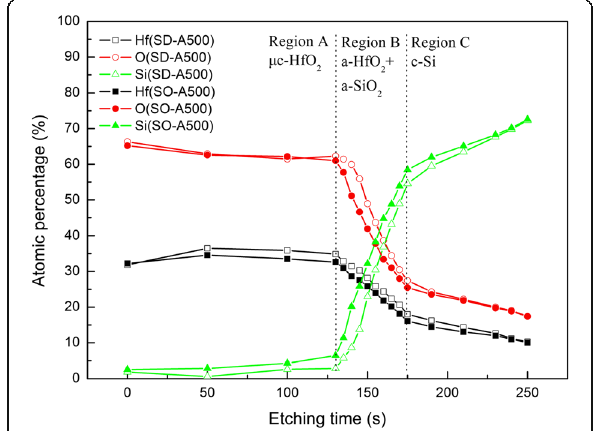
Fig. 4 Elemental depth profiles of HfO 2 annealed at 500 °C without and with O 2 plasma pretreatment versus etching